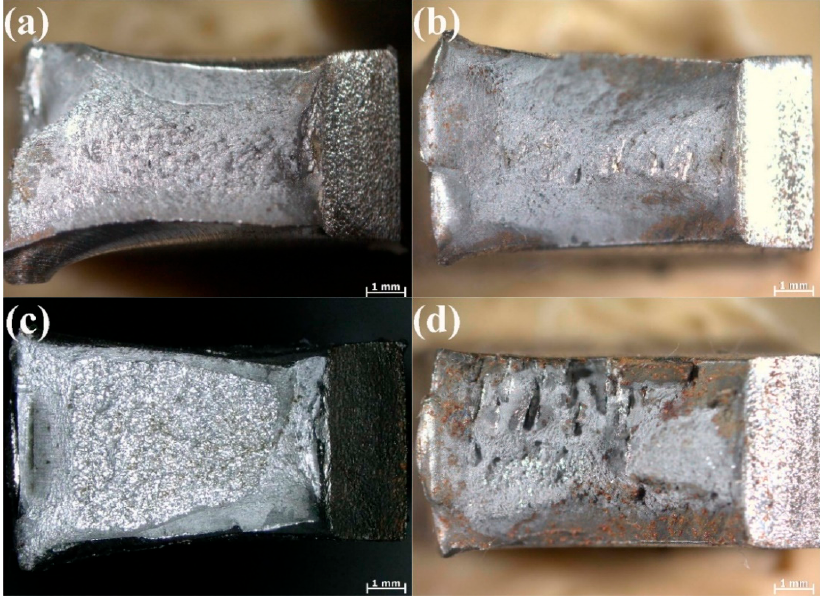
Figure 14. Impact macroscopic fracture morphology of welded joints with two welding methods: ( a ) HAZ-UDW joint; ( b ) FZ-UDW joint; ( c ) HAZ-ULCW joint; ( d ) FZ-ULCW joint.